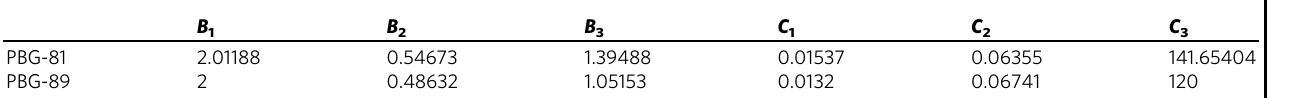
Table 2 Sellmeier coef fi cients for PBG-81 and PBG-89